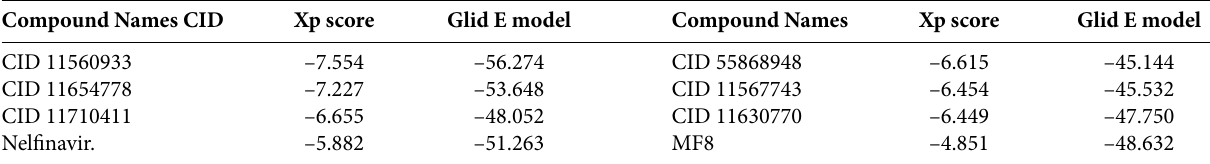
Table 4. Docking scores of the selected hits using GLIDE